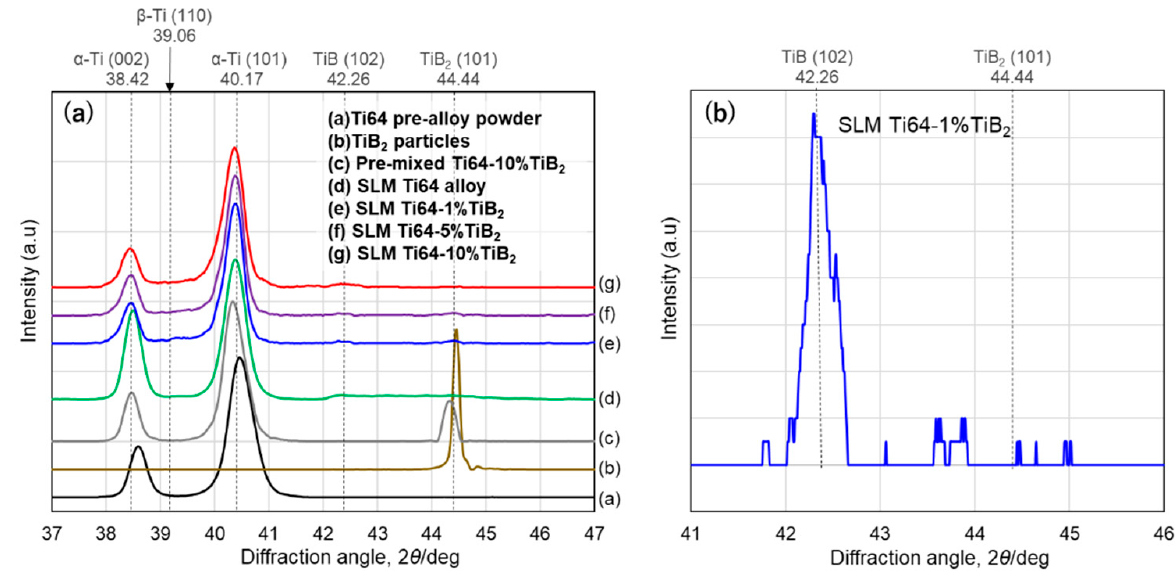
Figure 2. ( a ) XRD profiles of the Ti64 alloy powder, TiB 2 particles, pre-mixed Ti64-10%TiB 2 powder, SLM Ti64 alloy, SLM Ti64-1%TiB 2 alloy, SLM Ti64-5%TiB 2 alloy, and SLM Ti64-10%TiB 2 alloy. ( b ) Narrow-scanned XRD profile of the SLM Ti64-1%TiB 2 composite.